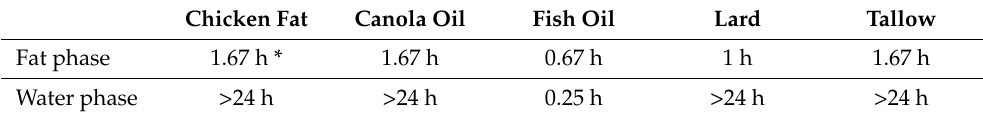
Figure 6. Mean logarithmic counts (log CFU/mL) of Salmonella spp. in different fat and oil systems with and without the inclusion of 0.10% SBS and 0.05% propionic acid evaluated separately for the aqueous phase and fat phase at 45 °C. Treatments from each phase were plated on TSA at different times. SBS, sodium bisulfate; CF, chicken fat; CO, canola oil; FO, fish oil; La, Lard; Ta, Tallow; Cont., control. Negative control consisted of fat-oil system without acidulant and Salmonella inoculation. The limit of detection is 1 log CFU/mL for this study. Because the three replications were averaged, for some of the treatments, the counts on 0 h appeared to be lower-than-detection limit. Error bars are ± 1 standard error of the mean. Table 3. Time to non-detection of Salmonella in control (without acidulant) fat or oil system.